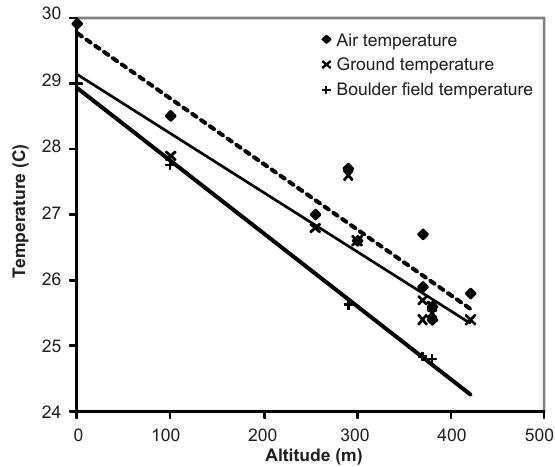
Figure 4. Microclimate effects on temperature - air, ground and boulder field